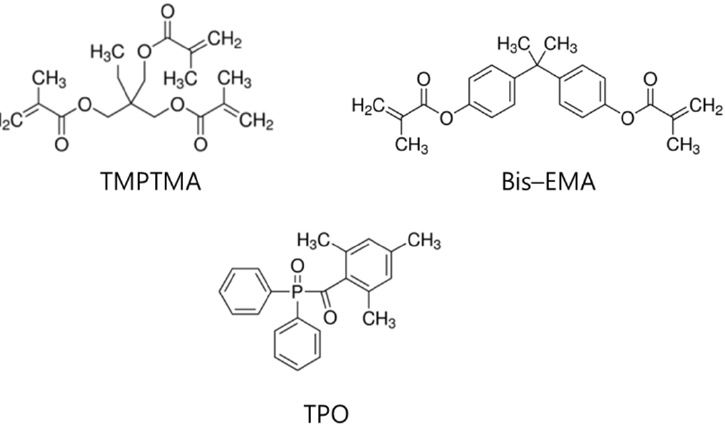
Figure 1. Chemical structure of the monomers (Bis-EMA and TMPTMA) and initiator